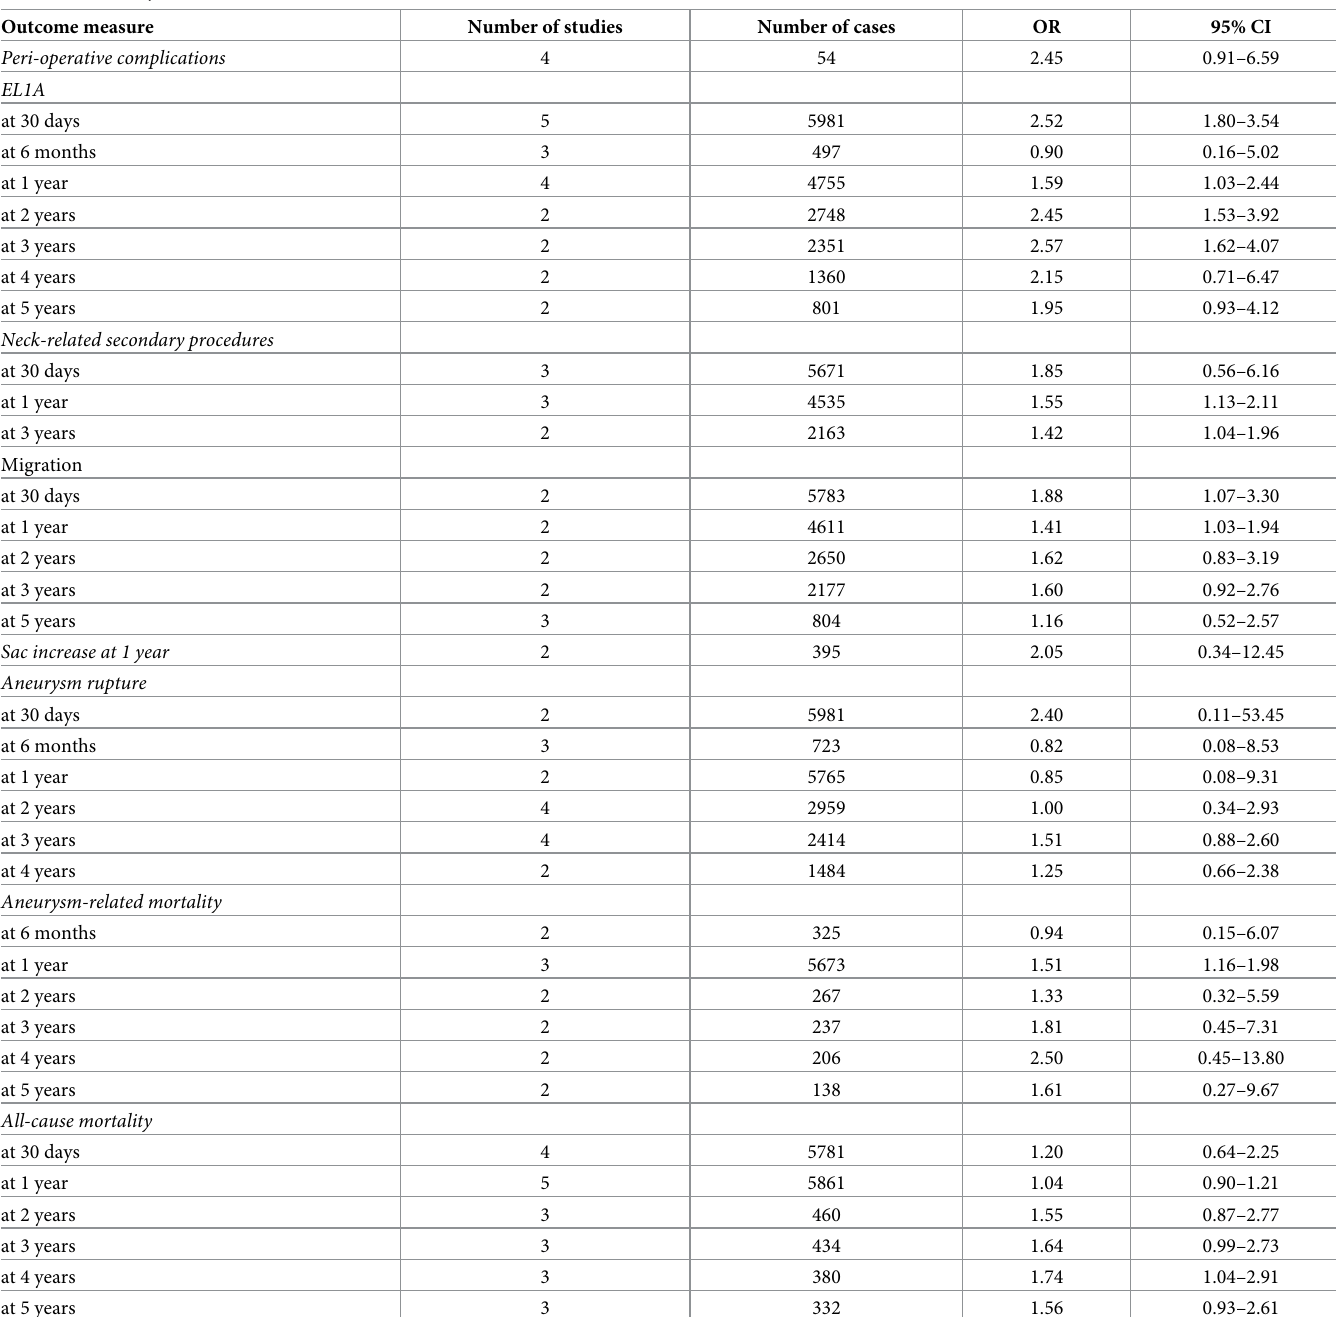
Table 3. Summary of